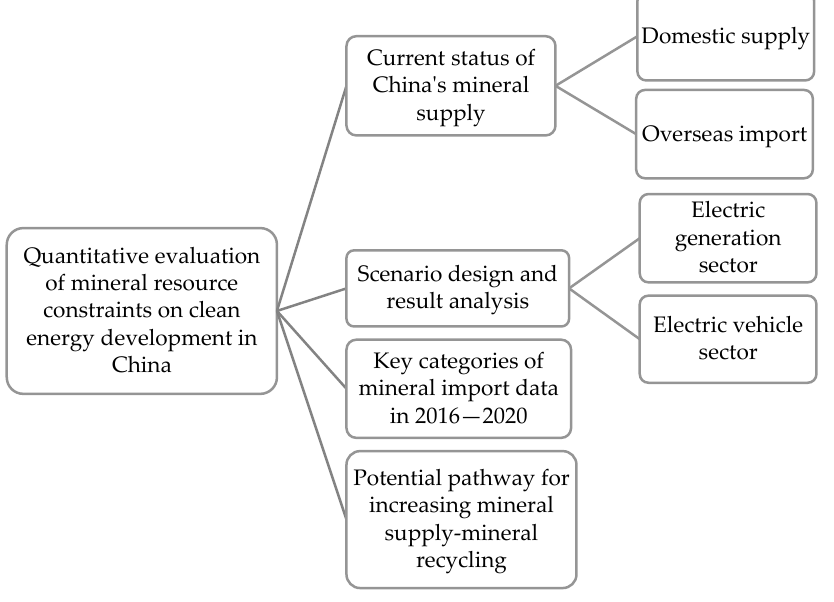
Figure 2. Research framework.